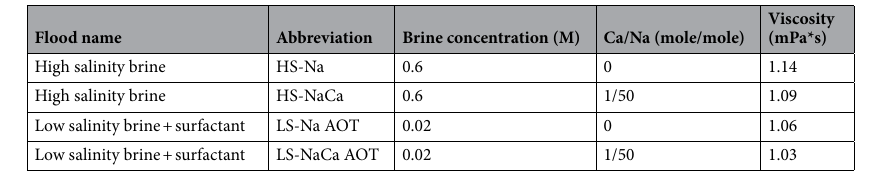
Table 4. Displacing fluid